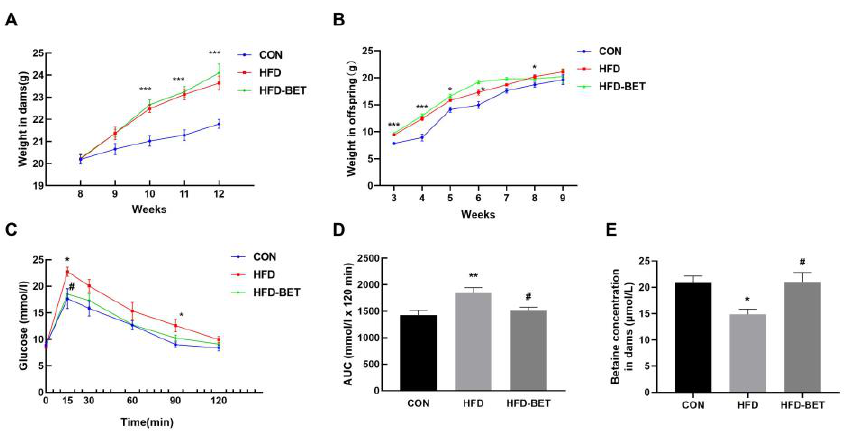
Figure 1. Body weight in dams and offspring mice and the GTT in dams. ( A ) Body weight in dams; ( B ) body weight in offspring mice; ( C ) serum glucose levels for the GTT in dams; ( D ) the AUC for the GTT in dams; ( E ) serum betaine levels in dams. Data are presented as the means ± SEM. * p < 0.05, ** p < 0.01 and *** p < 0.001 for the HFD group vs. the CON group; # p < 0.051 for the HFD-BET group vs. the HFD group. Abbreviation: CON group, control diet group; HFD group, high-fat diet group; HFD-BET group, high-fat diet + 1% betaine group. Table 2. Effects of maternal betaine supplementation on organ coefficients and serum biochemical parameters in offspring mice .